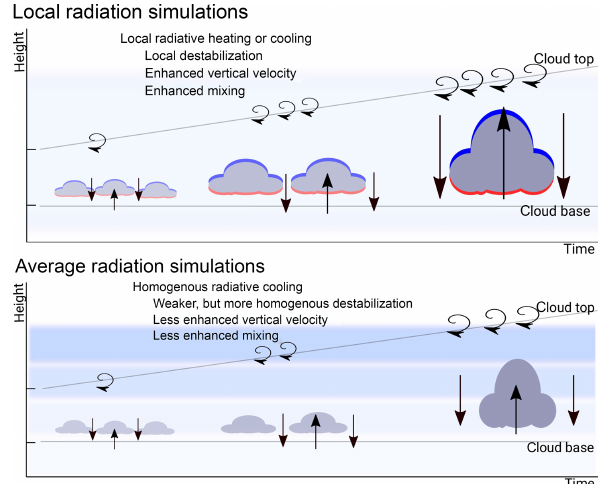
Figure 18. Schematic figure of the effects of thermal radiation in the presented simulations. The figure summarizes cloud develop- ment over time and height, showing the enhanced cloud growth, the development of vertical velocity (arrows), a deepening of the cloud layer and the enhanced mixing. Blue and red colors show thermal heating and cooling, either in the cloud itself (for local radiation) or averaged in the cloud